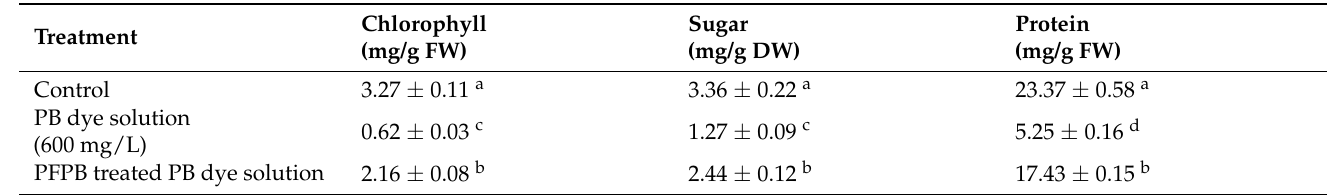
Table 6. Impact of Patent Blue before and after PFPB treatment on biochemical variables of Lens culinaris variety